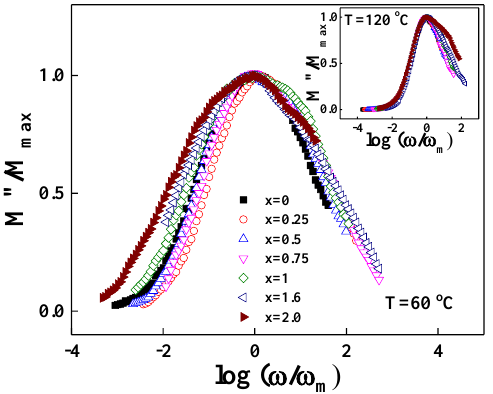
l og (  /  h ) Figure 7. The master curve of 3Li 2 O-(2-x)Fe 2 O 3 -xMn 2 O 3 -3P 2 O 5 (x = 0, 0.25, 0.5, 0.75, 1.0, 1.6, 2.0) glasses exhibits the fact that the substantially differing ion concentration plot satisfies the common scaling, σ(ω h ) = 2σ dc . Figure 8 shows the master plots for the electrical modulus, M ′′ (ω)/M”(ω) max vs.